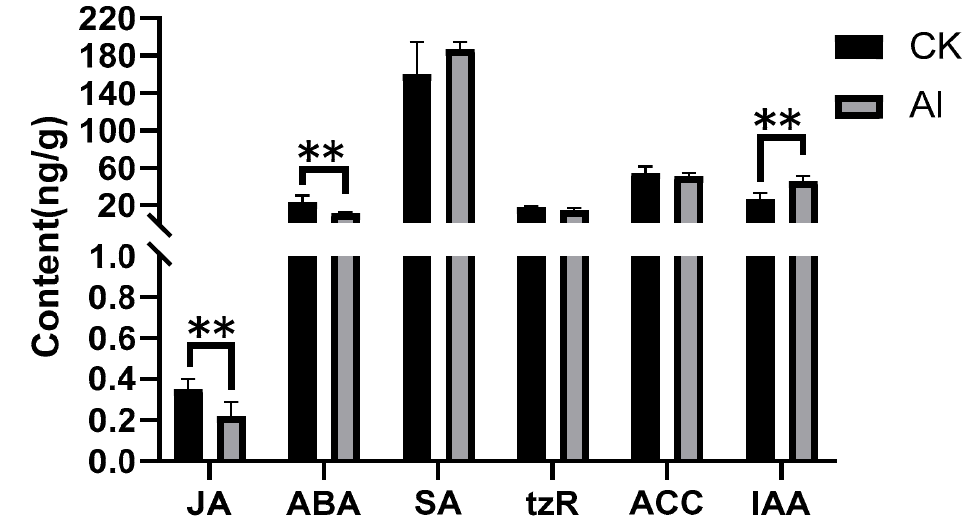
Figure 2. The difference in the content (ng/g) of six hormones (JA, ABA, SA, tzR, ACC, and IAA) in tea root base for the CK and 0.4 mmol/L Al groups (** indicates significance at 0.01 probability level). To determine whether the promotion of root growth under Al was related to IAA distribution, root bases were collected to examine the endogenous IAA levels using HPLC. The IAA concentration reached 66.62 ng/g after 6 h, which was significantly higher than that of the control plants (Figure 3A). After 7 d, the IAA concentration decreased in Al- exposed plants but was still significantly higher than in control plants. This indicates that Al may promote the accumulation of IAA in roots to accelerate the growth of LRs in tea plants. Two experiments were carried out to further verify whether the promotion of root growth under Al was related to IAA distribution. The IAA concentration in the root tips in the Al group was significantly lower than that of the CK group after the roots were treated for 6 h by the IAA synthesis inhibitor AVG, and there was no difference when the tea plants were treated for 24 h and 7 d (Figure 3B). When the roots of tea plants were treated for 6 h by the IAA transport inhibitor, the IAA concentration in the root tips of the Al group was significantly higher than that of the CK group, but it remained at a relatively low level in the root stem and root base (Figure 3C). When the incubation time reached 24 h, the IAA content began to decrease in the root tips, but the IAA concentration in the root tips of the Al group was still significantly higher than that of the CK group, and the IAA content in the root base began to increase (Figure 3D). When the incubation time reached 7 d, the IAA concentration in the root tips of the Al-treated group was significantly lower compared with the CK group, whereas the IAA concentration in the root stem and root base was significantly higher (Figure 3E). Hence, the concentration of Al may affect the synthesis and transportation of IAA and lead to IAA accumulation in the roots of tea plants to stimulate LR